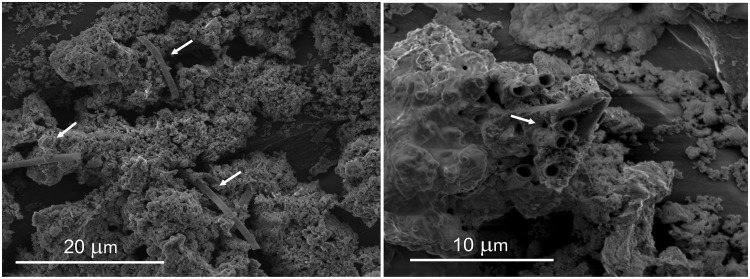
Environmental scanning electron microscope (E-SEM) images of materials extracted from pore water from after-filter sand grains at the Islevbro DWTP. Biogenic remains (arrows) are visible between the mineral Fe(III) oxyhydroxide precipitates.